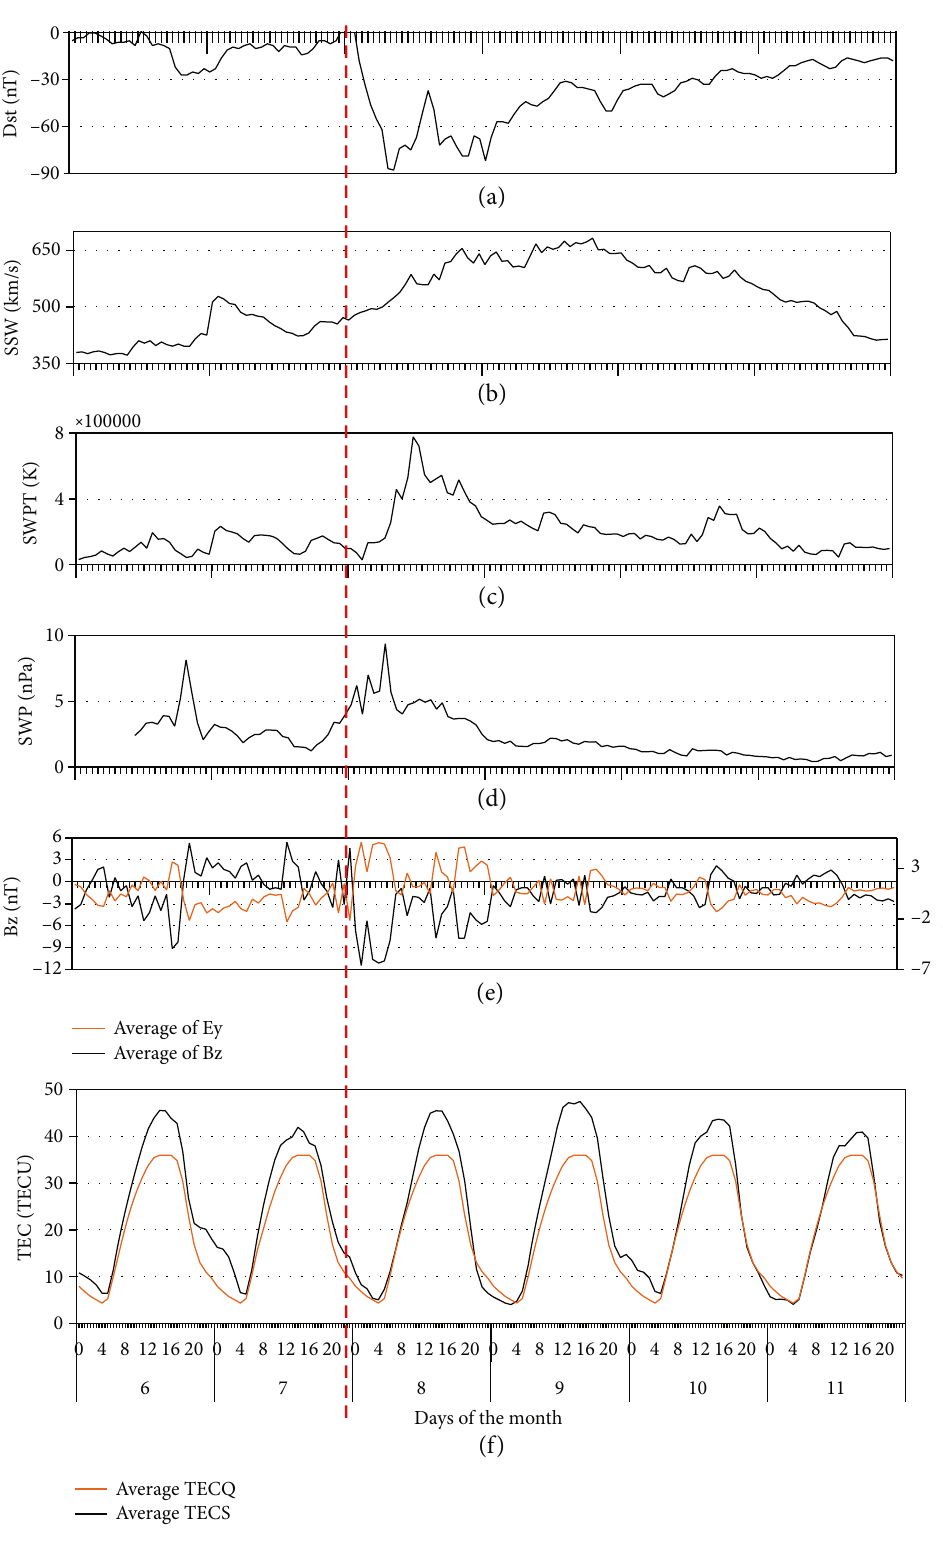
Figure 5: Variation of solar wind parameters and total electron content (TEC) from May 06 to 11, 2016, at the Koudougou GPS